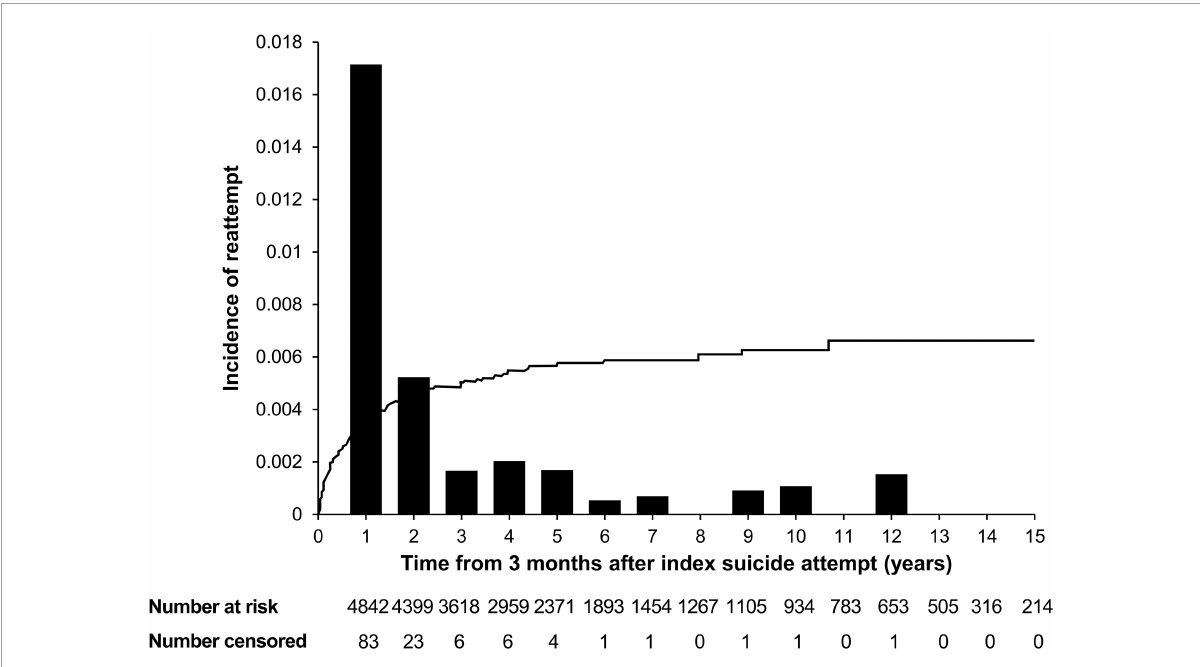
FIGURE1 Incidence of suicide reattempt after an index suicide attempt. Incidence of suicide reattempt among individuals who visited clinics with attempted suicide from 3 months after the index suicide attempt. The line represents the cumulative incidence of suicide reattempt after the index suicide attempt, while the bars represent the yearly incidence of suicide reattempt after the index suicide attempt. Yearly incidence: Year 1 = 1.7%, Year 2 = 0.5%, Year 3 = 0.2%, Year 4 = 0.2%, Year 5 = 0.2%, Year 6 = 0.1%, Year 7 = 0.1%, Year 8 = 0%, Year 9 = 0.1%, Year 10 = 0.1%, Year